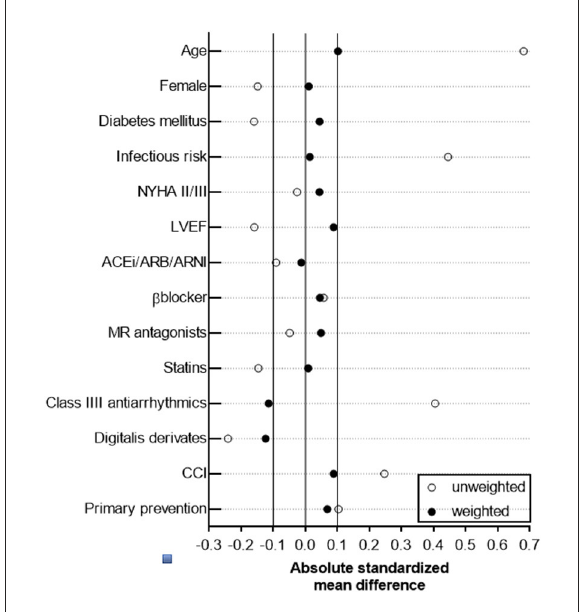
FIGURE1 Forrest plot for standardized mean differences of covariates included in the IPW model.